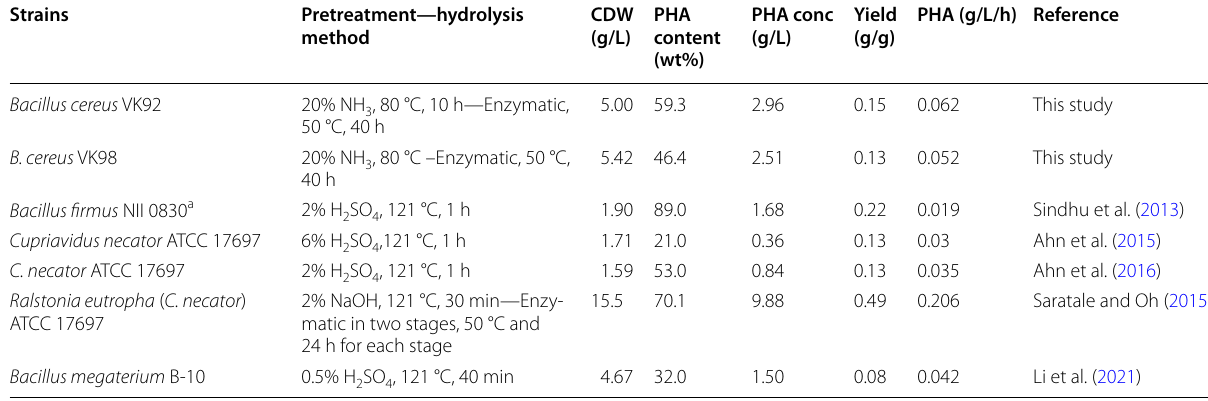
a PHB analysis using spectrophotometric